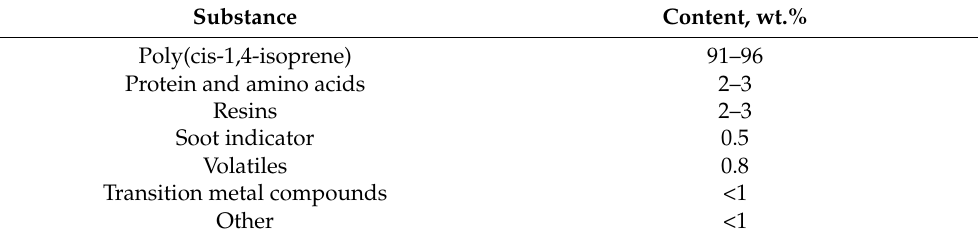
Table 1. Chemical composition of natural rubber (NR), grade SVR 3